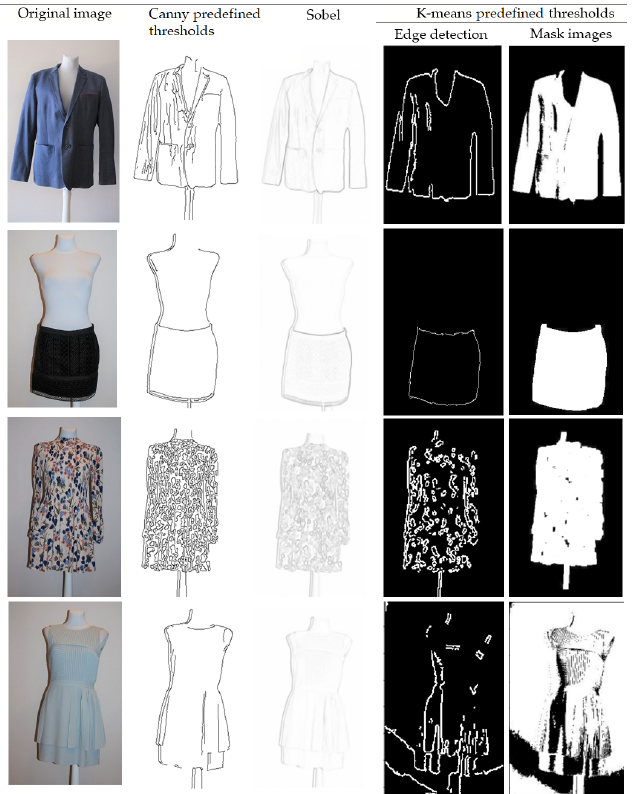
Figure 3. Results of different contour detection techniques: Canny algorithm with predefined threshold values, Sobel algorithm and K-means based thresholding algorithm providing edge and mask